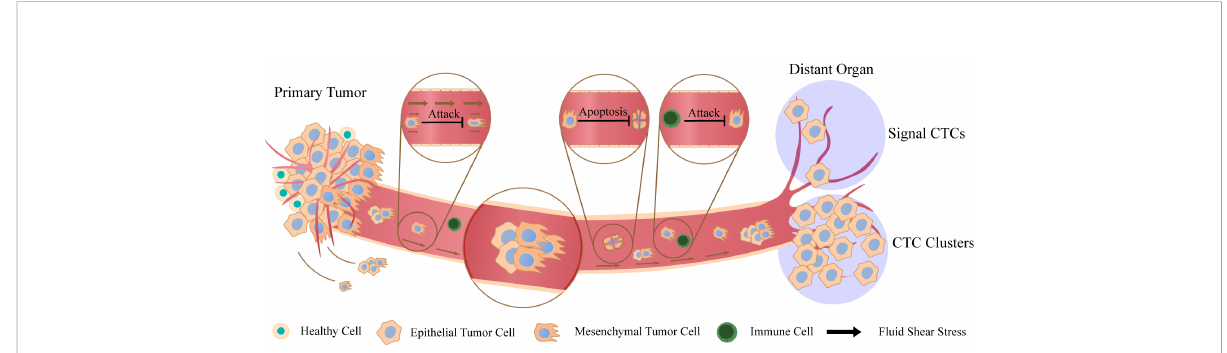
FIGURE 1 Metastasis of circulating tumor cells (CTCs) and CTC clusters Cancer cells fall off from the primary sites and enter the blood circulation. They can exist by the form of single cells or aggregated cell clusters. There are various factors in peripheral blood (PB) that are not conducive to the survival of cancer cells. Cancer cells will be attacked by fl uid shear stress and immune system, and signal CTCs also induce apoptosis due to the loss of intercellular contact. Finally, they reach distant organs and continue to spread, and CTC clusters have stronger metastatic potential compared to signal